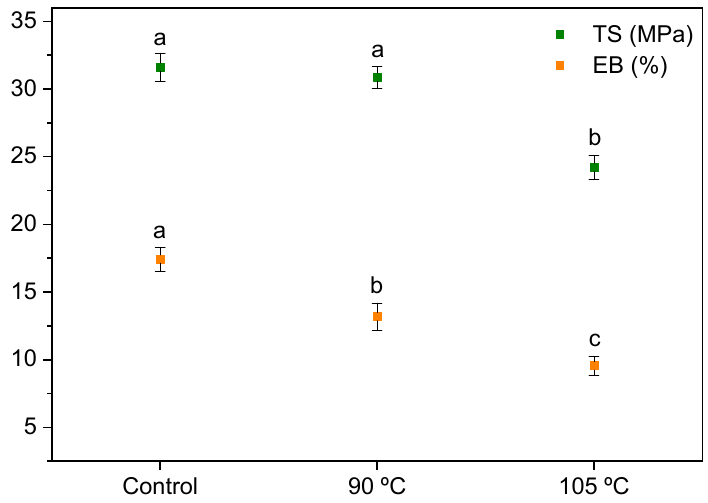
Figure 3. Tensile strength (TS) and elongation at break (EB) of control and thermally treated films. Two means followed by the same letter for the same color are not significantly ( p > 0.05) different through Tukey’s multiple range test.